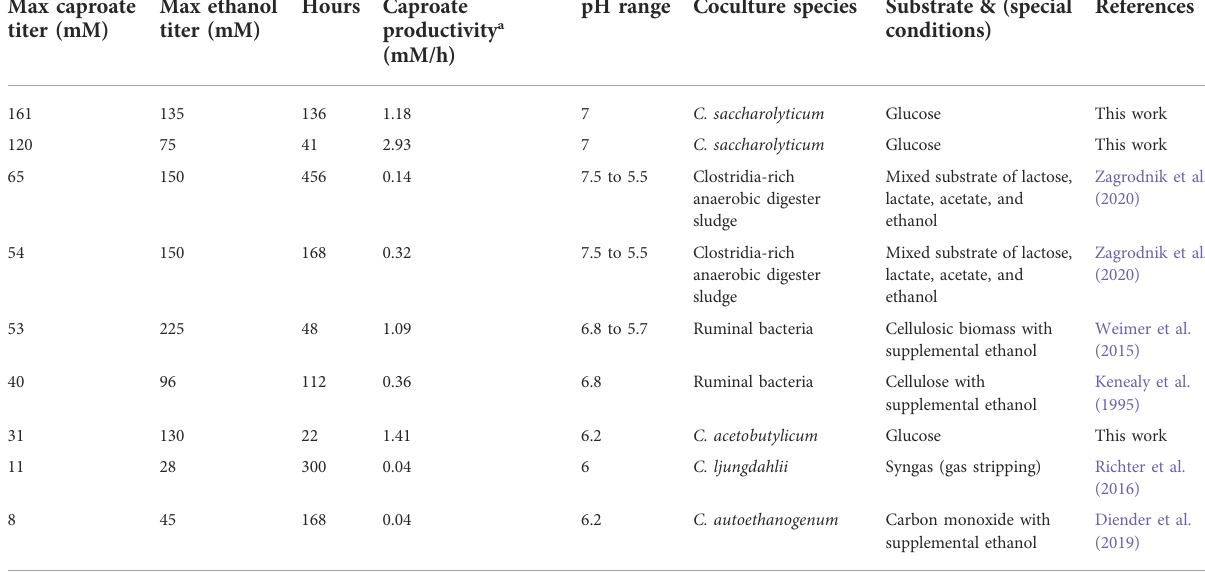
TABLE 2 Caproate titers, production rates, and coculture partners of Ckl cocultures. Max caproate titer